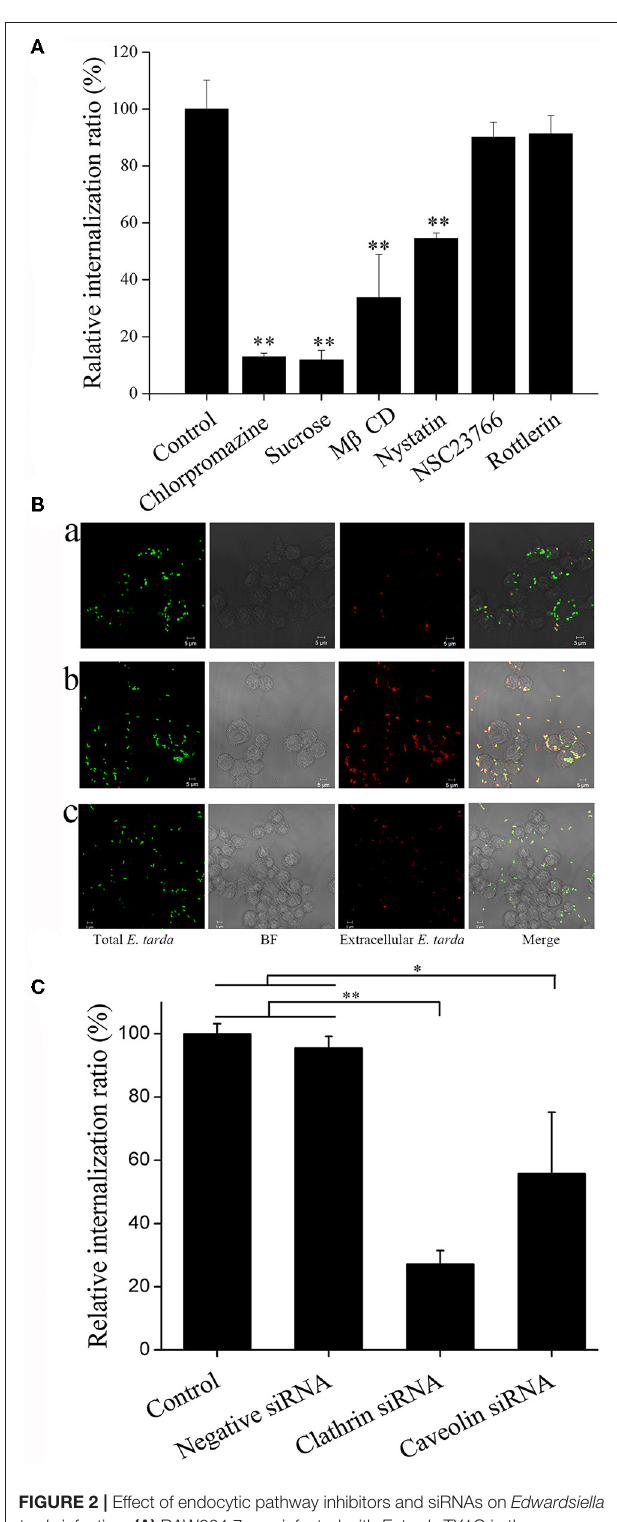
FIGURE 2 | Effect of endocytic pathway inhibitors and siRNAs on Edwardsiella tarda infection. (A) RAW264.7 was infected with E. tarda TX1G in the presence or absence (control) of various endocytic pathway inhibitors, and cellular internalization of the bacteria was determined by plate count. (B) RAW264.7 was infected with TX1G in the presence of chlorpromazine (b) and nystatin (c) ;